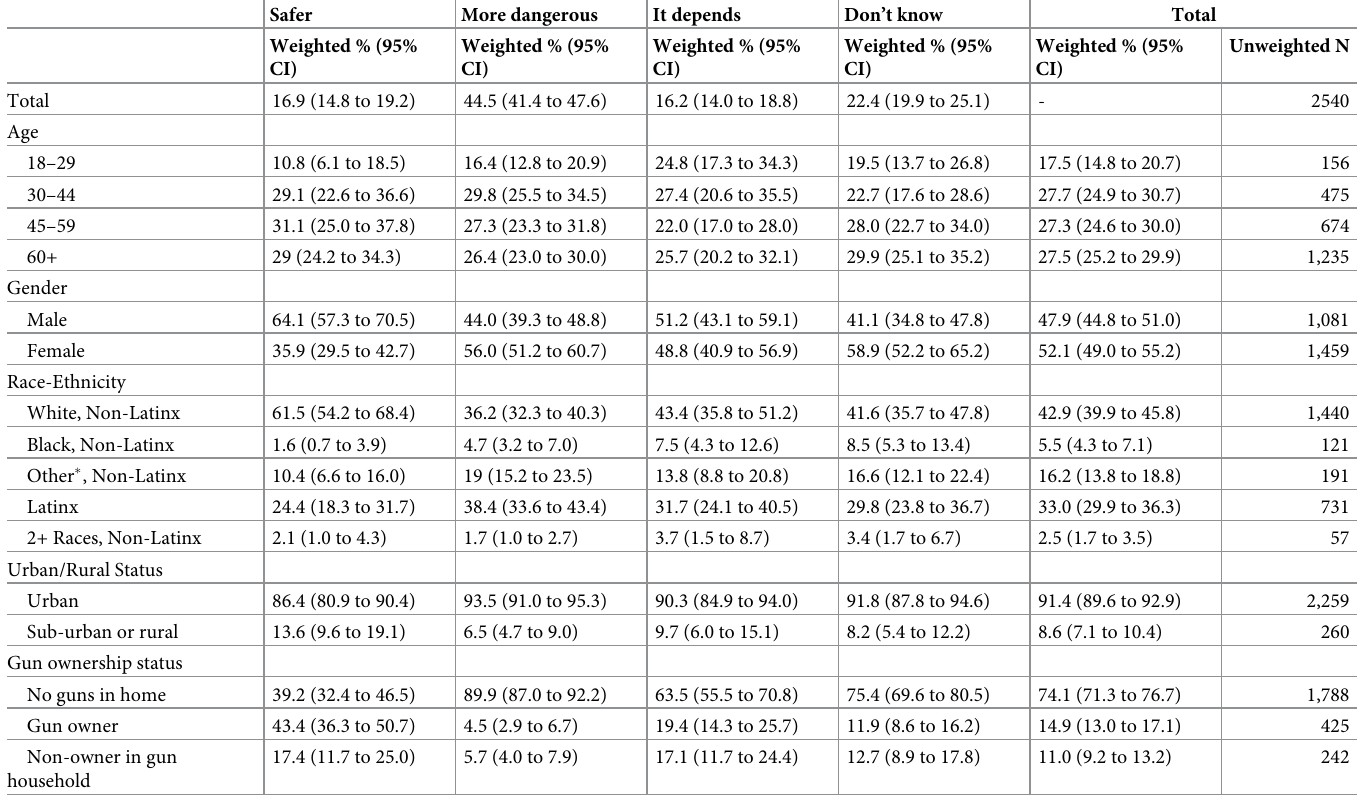
Table 2. If everyone in your neighborhood had guns at home, would that make your neighborhood a safer place to be, or a more dangerous place to be?, by demo- graphics and gun ownership status. Safer It